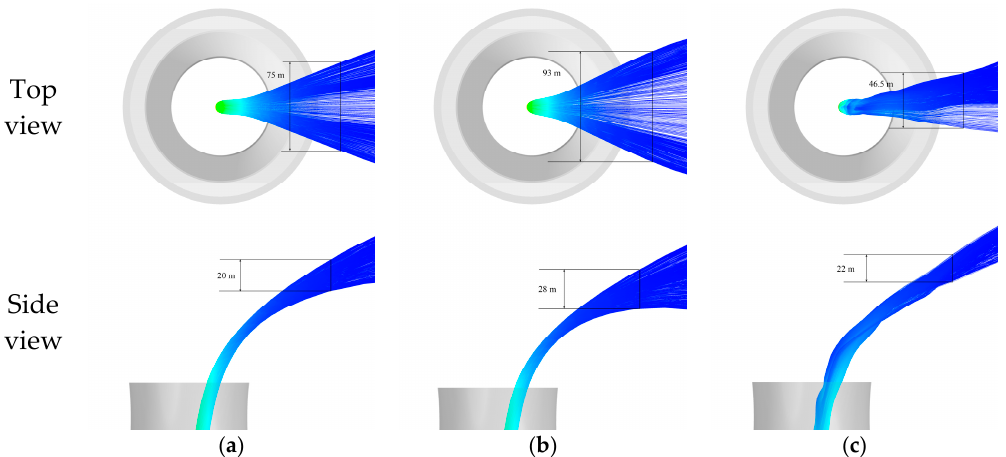
Figure 23. Comparisons of streamlines extension range at 100 m downstream of cooling tower (x = 100) : ( a ) RANS; ( b ) URANS; ( c ) LES.